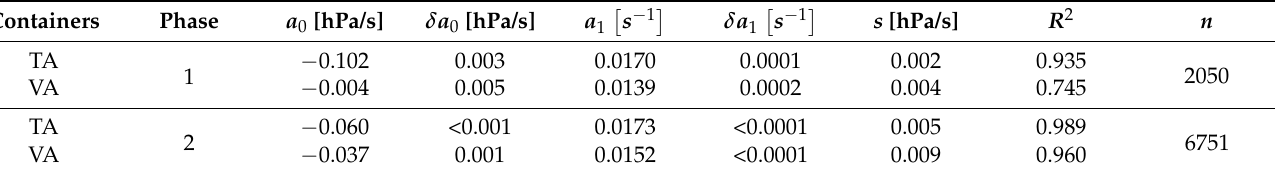
Table A4. Fit parameters for the linear model α ( ∆ e (cid:48) w ) according to Equation (22) for Experiment 2, fitted to the measurements taken in the various containers and experimental phases ( δ —standard error, s —standard deviation of residuals, R 2 —squared correlation coefficient, n —number of data).